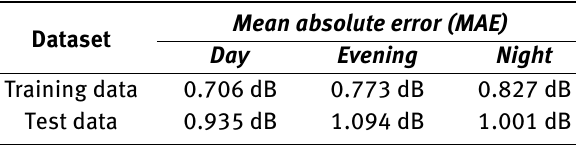
Table 7: Accuracy of the model with scaling functions at location no.